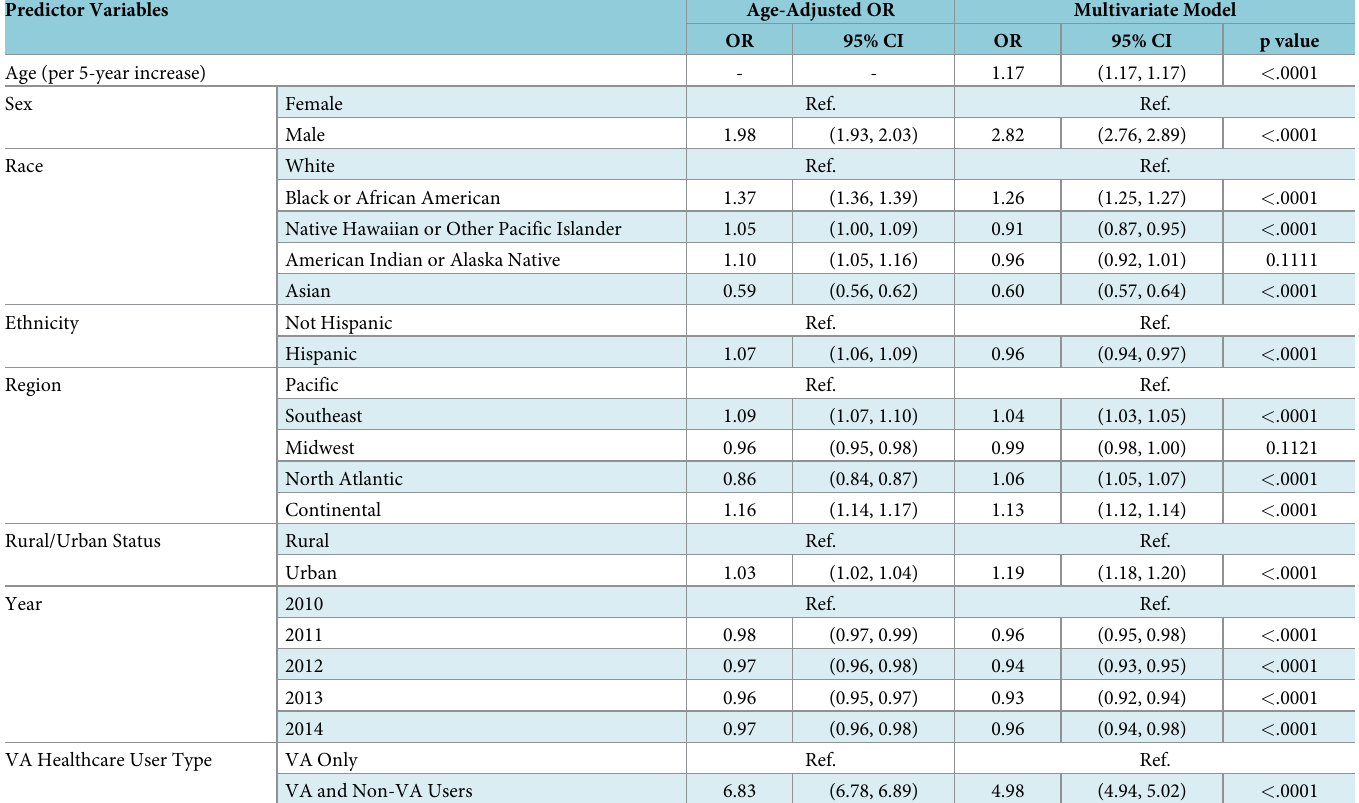
Table 3. Age-adjusted and multivariate models evaluating predictors of cardiovascular hospitalization due to one or more of the top 5 cardiovascular conditions ‡. Predictor